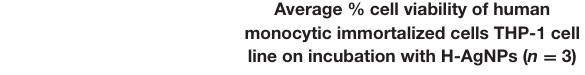
TABLE 1 | Table showing the cytotoxic effects of H-AgNPs at different concentrations for 24–72